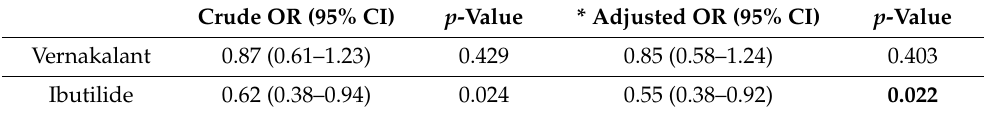
Table 5. Impact of body weight on cardioversion success for both